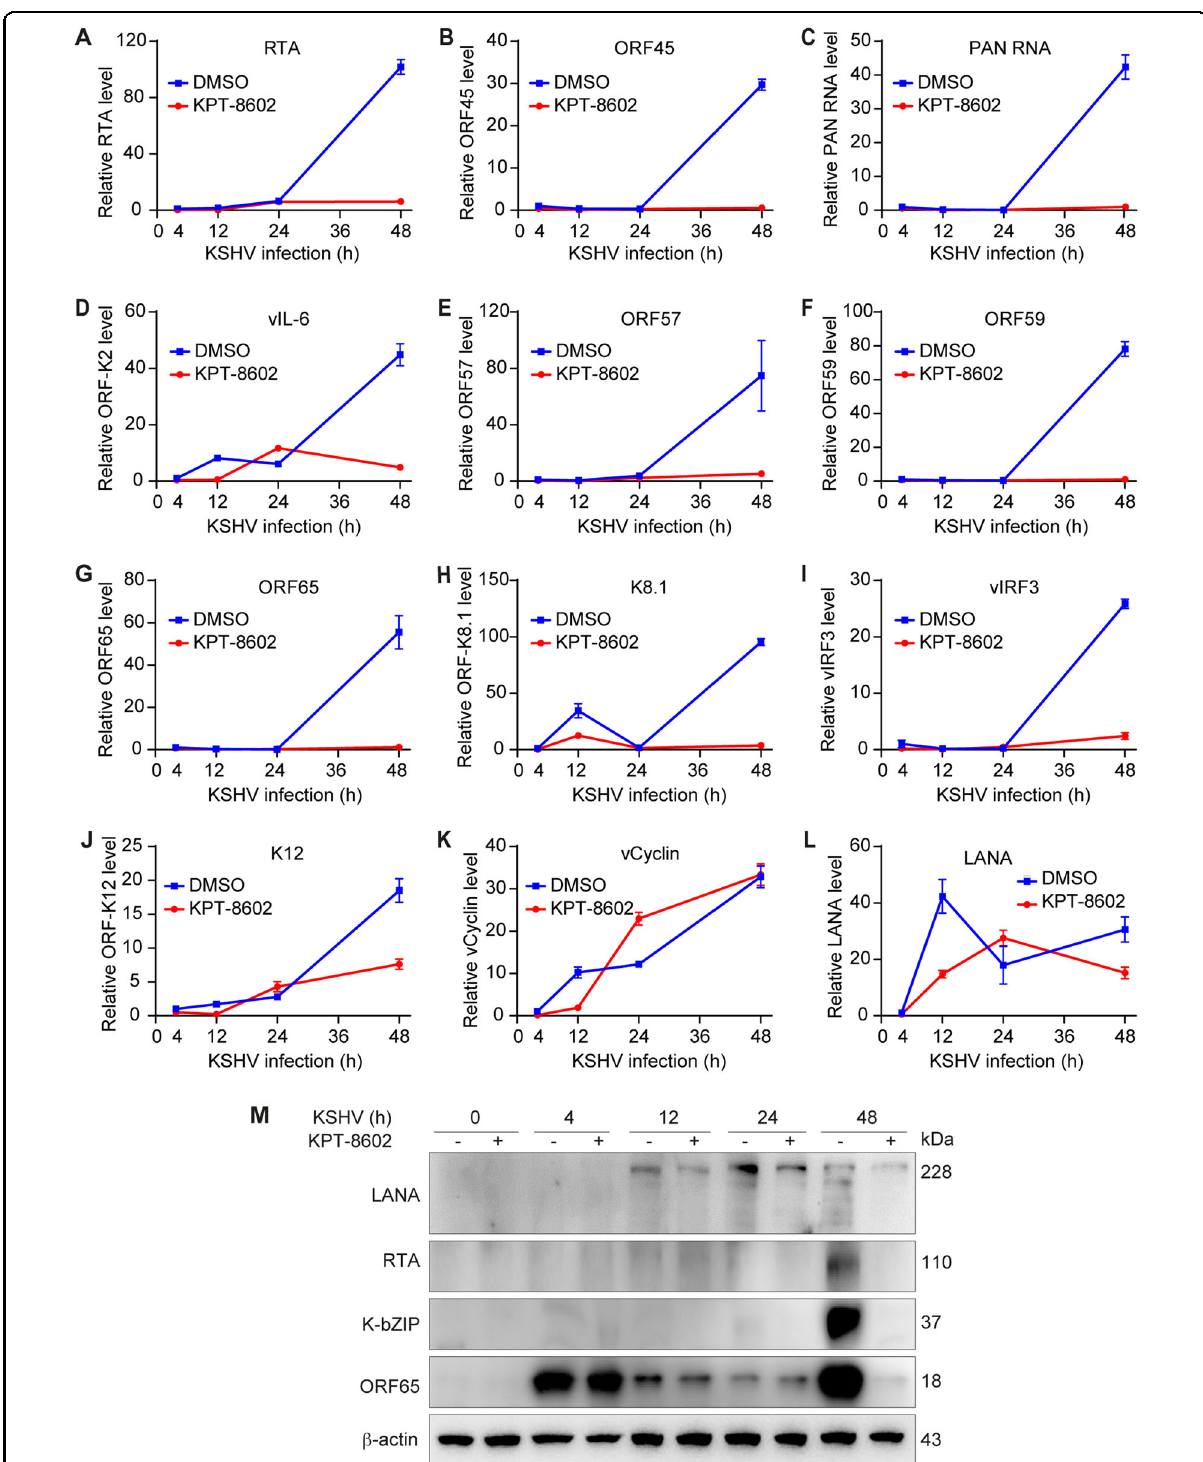
Fig. 2 XPO1 inhibitor KPT-8602 inhibits the expression of KSHV genes except for LANA and vCyclin genes during primary infection. A – L HUVEC were pretreated with 0.5 µM KPT-8602 for 1 h and then infected with KSHV in the presence of KPT-8602 for 4, 12, 24, 36, and 48 h. Cells were collected for RNA extraction and examined for the expression of KSHV transcripts by RT-qPCR. M HUVEC were pretreated with 0.5 µM KPT-8602 for 1 h and then infected with KSHV in the presence of KPT-8602. The cell lysate was collected at 4, 12, 24, and 48 hpi and analyzed for the expression of viral proteins by Western blotting. β -actin served as the loading